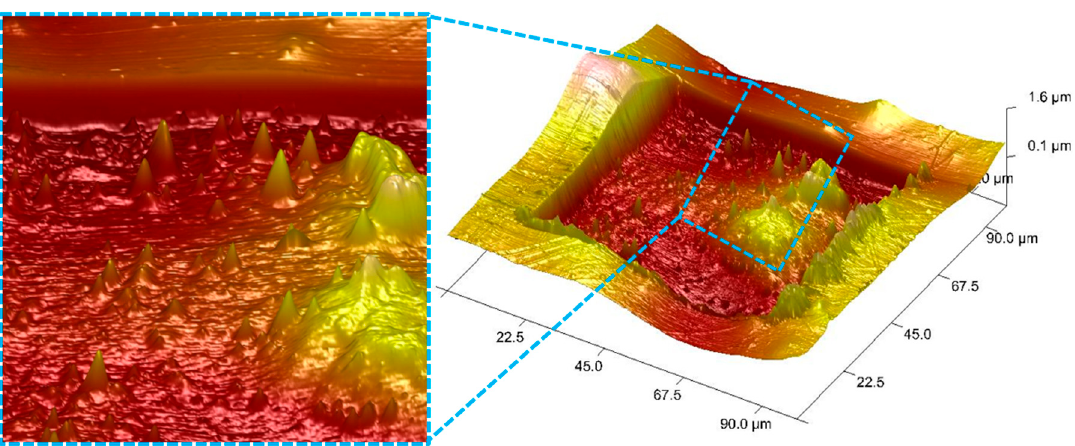
Figure 11. 3D surface topography of sample g-0.5 after scratching the surface with a 100 µ m by 100 µ m scan area at a set-point voltage of 0 V. On the left, focus on the performance of individual fGO flakes.